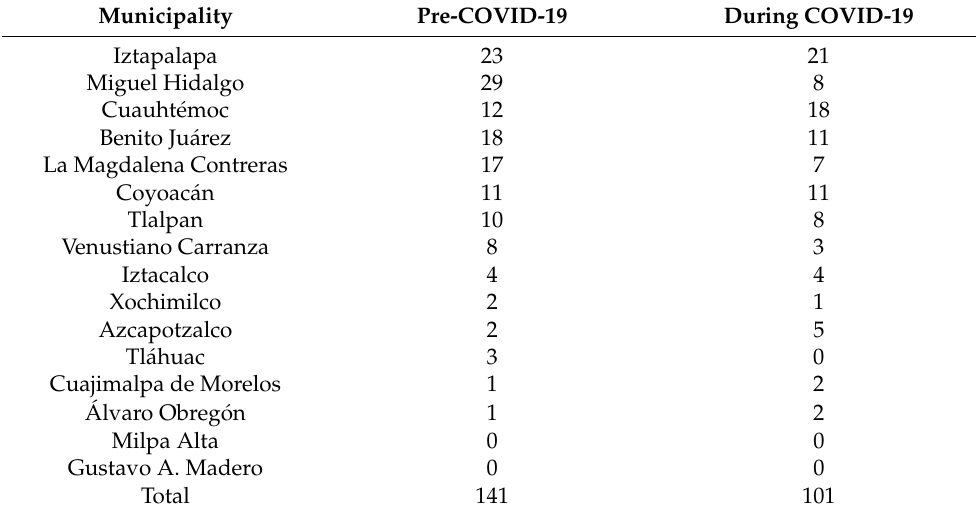
Table 4. Number of tweets per